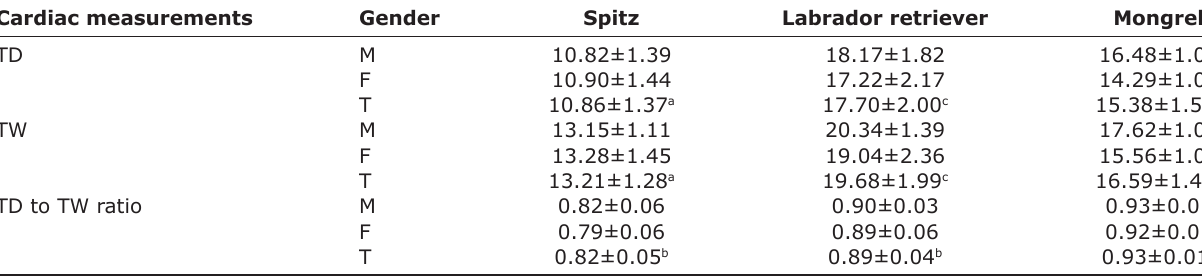
Table-5: TD, TW and TD to TW ratio in Spitz, Labrador retriever and Mongrel dogs. Cardiac